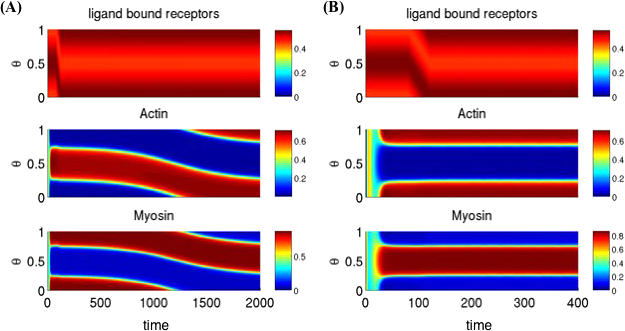
Predicted Effect of Ras Gap Mutation and Constitutively Active Ras(A) Ras gap mutation was simulated by decreasing the rate of Ras deactivation (dR) by a factor of 10. The model still polarizes towards the gradient of attractant, but its response to a rotating gradient is slower.(B) Constitutively active Ras was simulated by setting the Ras deactivation rate (dR) to zero. The model polarizes towards the chemoattractant but cannot track a rotating gradient.